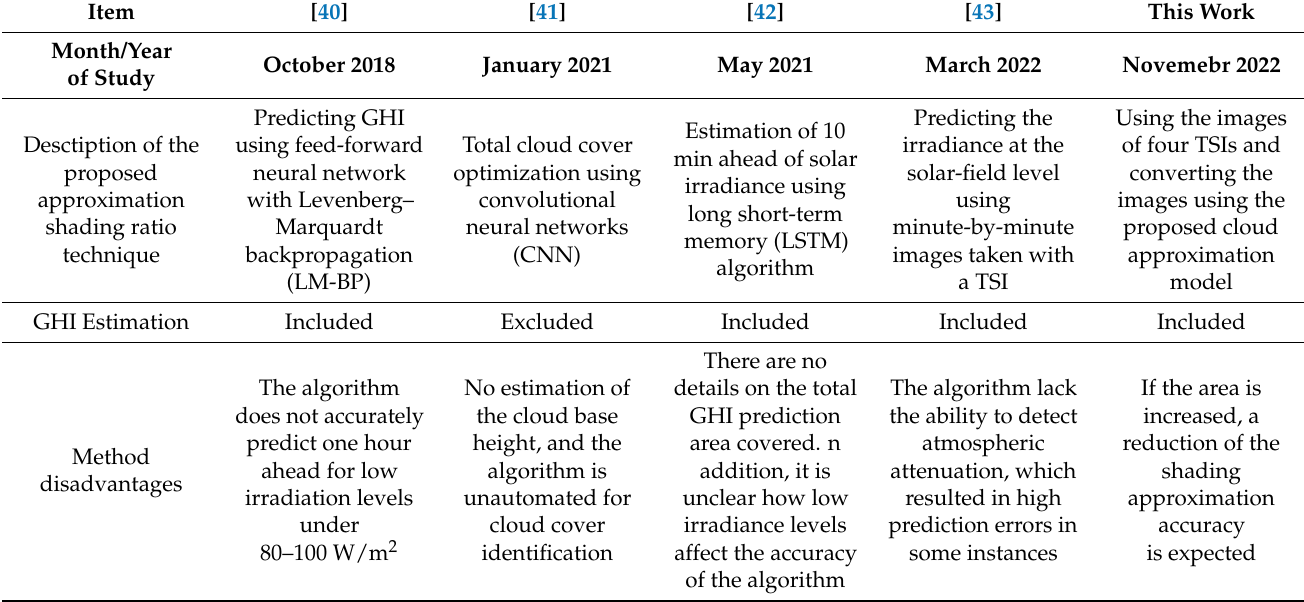
Table 3. Comparison of this work and previously published papers